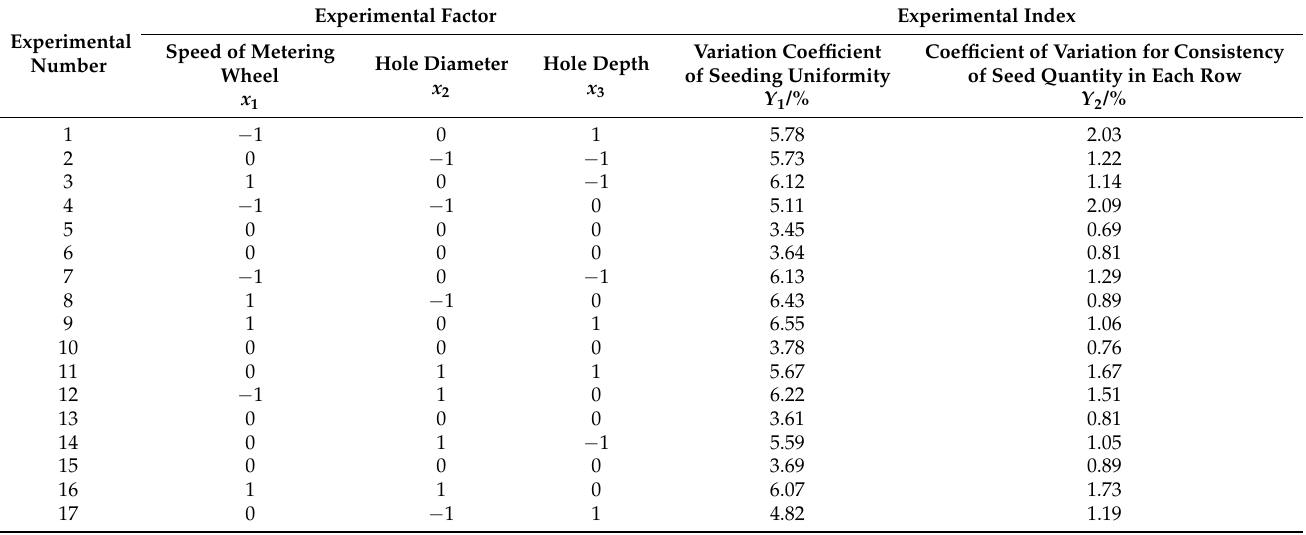
Table 3. Protocols and